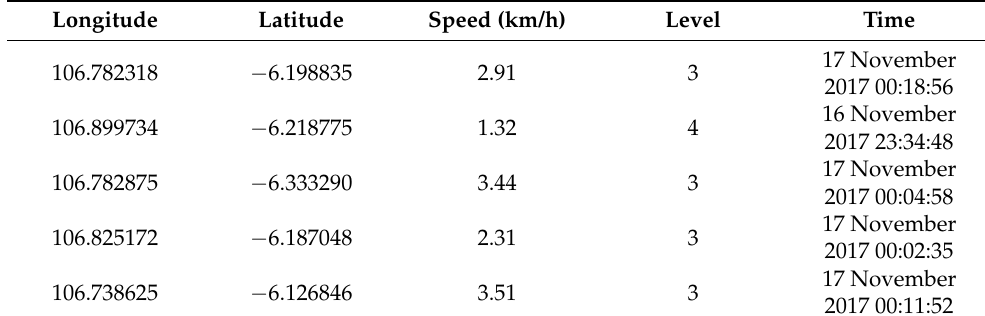
Table 2. Examples of Dataset #1.